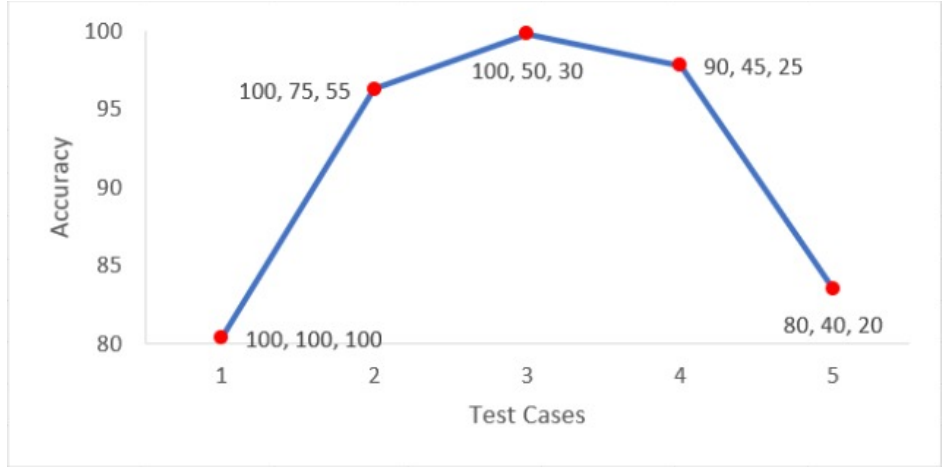
Figure 7: Classification accuracy versus varying number of cells in three hidden layers for the proposed BLSTM architecture Table 4: Performance results of proposed models